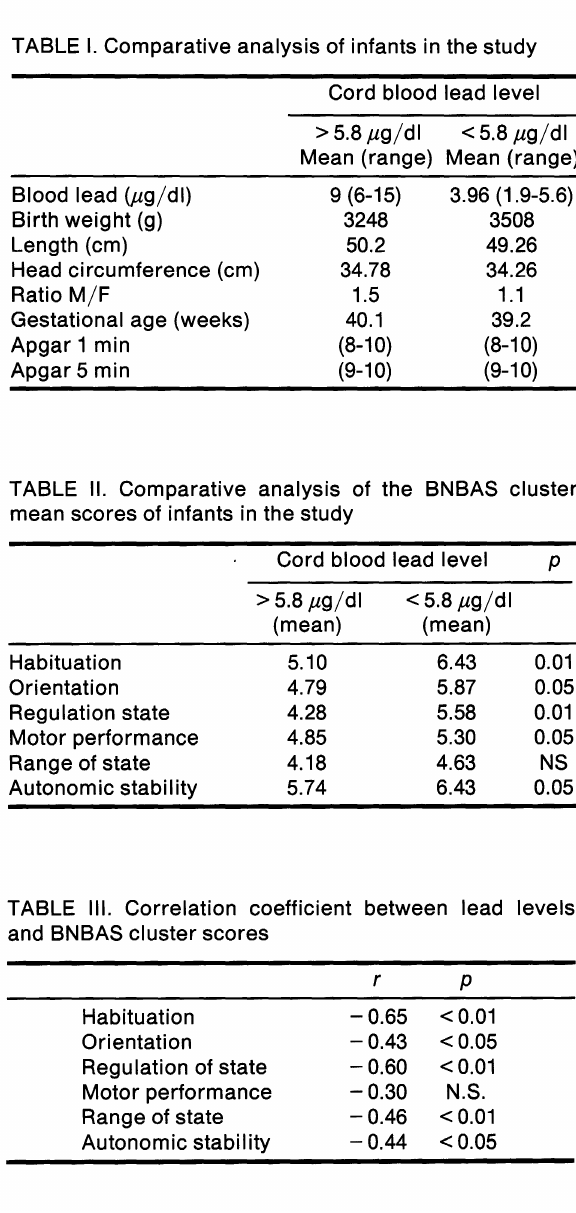
Table III. Habituation, orientation, regulation of